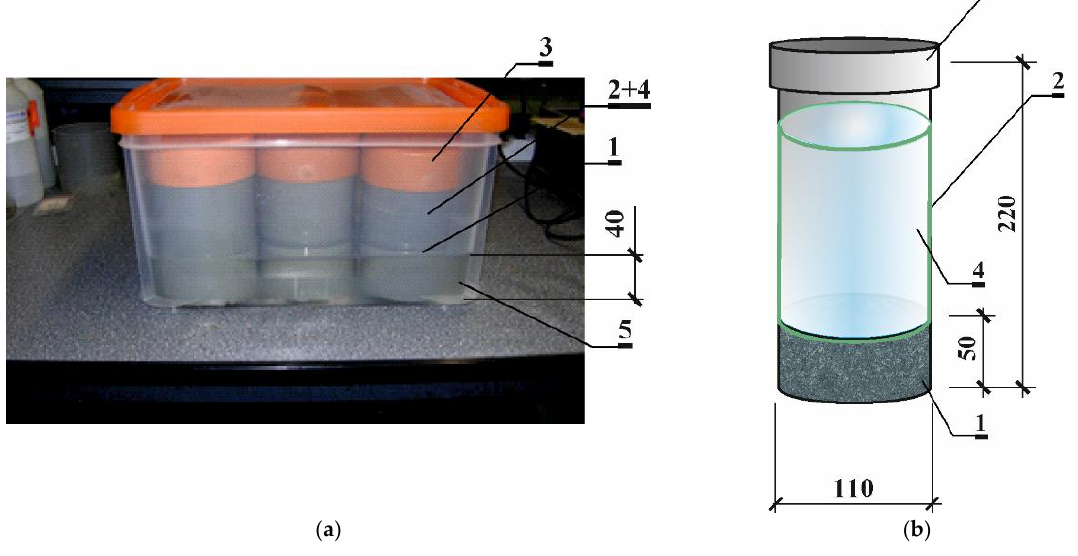
Figure 1. View of the stand ( a ) and the research elements ( b ) in the diffusion test: 1 — concrete re- search element, 2 — tank for source 3% NaCl solution, 3 — conventional plugs to reduce evaporation, 4 — 3% NaCl solution, 5 — distilled H 2 O. evaporation, 4—3% NaCl solution, 5—distilled H 2